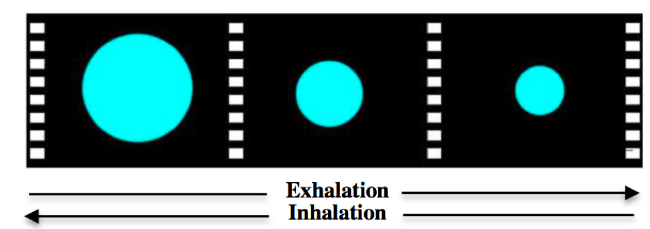
Figure 2. Relaxation exercise: the patient inhales as the animation grows, then exhales as it